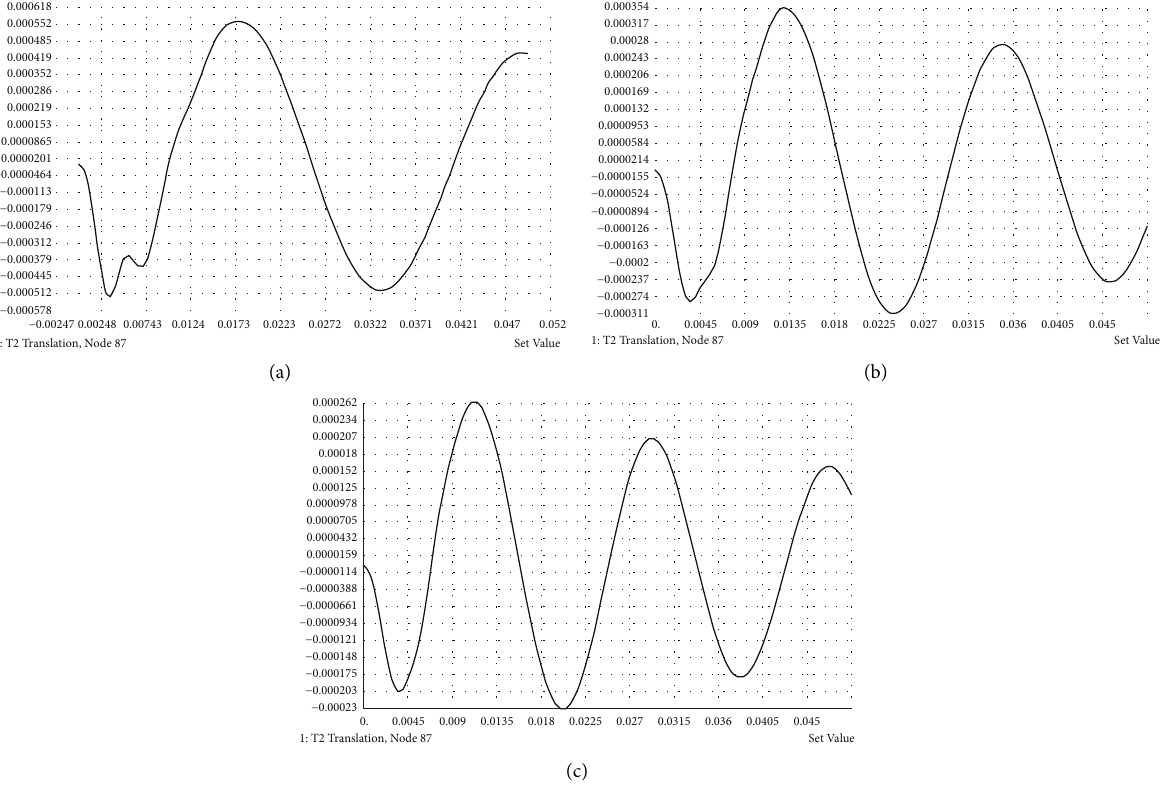
Figure 14: Amplitude v/s time for (a) 50-50%, (b) 60-40%, (c) 70/30% glass/epoxy composite plate. Table 4: Values of frequency for mode 1, logarithmic decrement, and damping coefficient. Composition